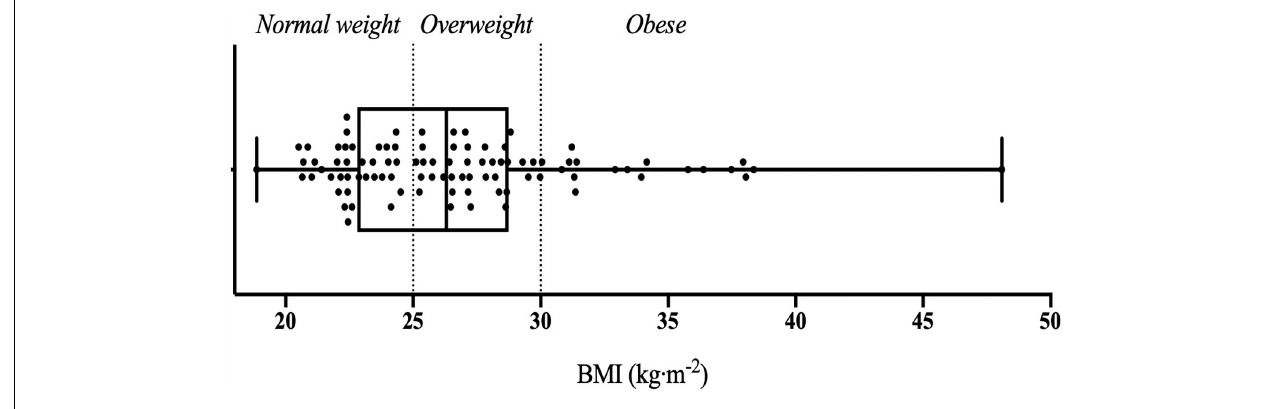
FIGURE 1 | Whisker plot illustrating individuals’ BMI across three BMI groups classified as normal weight, overweight, and obese. TABLE 2 | Summary of Mean ± SD values of hormonal measures and olfactory functions across BMI groups with results from One-way ANOVAs assessing the effect of BMI groups on each testing variables. Normal weight Overweight Obese ANOVA